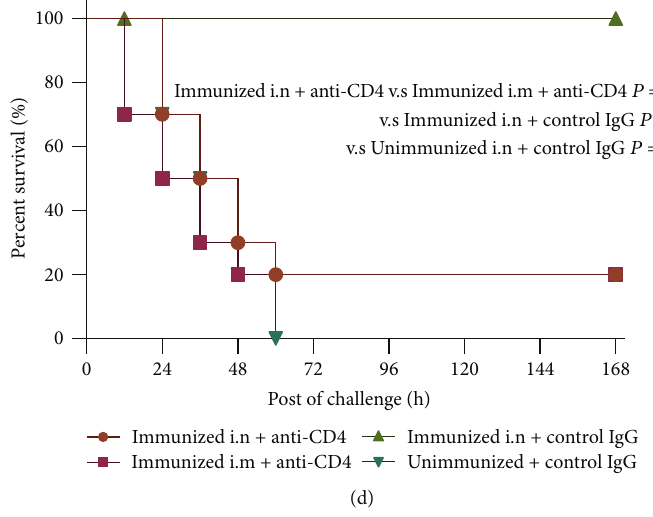
Figure 2: CD4 T cells are essential for rePcrV-mediated protection in Pseudomonas aeruginosa pulmonary infection. (a) Survival in the mice (immunized SCID i.m.), and unimmunized SCID rePcrV + curdlan vaccinated mice (immunized SCID i.n.), rePcrV + Al(OH) 3 mice (immunized μ MT mice ( n = 10 ). (b) Survival in the rePcrV + curdlan vaccinated mice (immunized μ MT i.n.), rePcrV + Al(OH) 3 i.m.), and unimmunized μ MT mice ( n = 10 ). (c) Survival in the rePcrV + curdlan vaccinated mice (immunized CD8 - / - i.n.), rePcrV + mice (immunized CD8 - / - i.m.), and unimmunized CD8 - / - mice ( n = 10 ). (d) Survival in the rePcrV + curdlan vaccinated mice Al(OH) 3 mice (immunized i.m. + anti-CD4), rePcrV + curdlan vaccinated mice (immunized i.n. + anti-CD4), rePcrV + Al(OH) 3